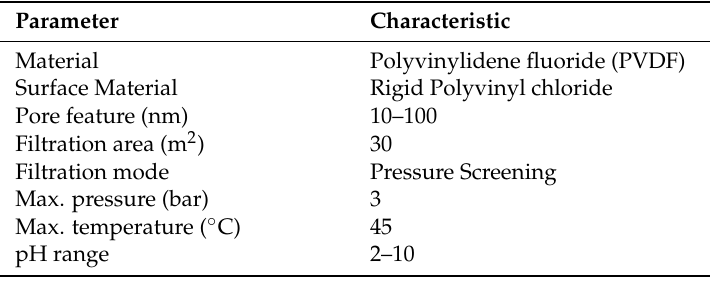
Table 3. Characteristics of hollow fiber ultrafiltration membranes.